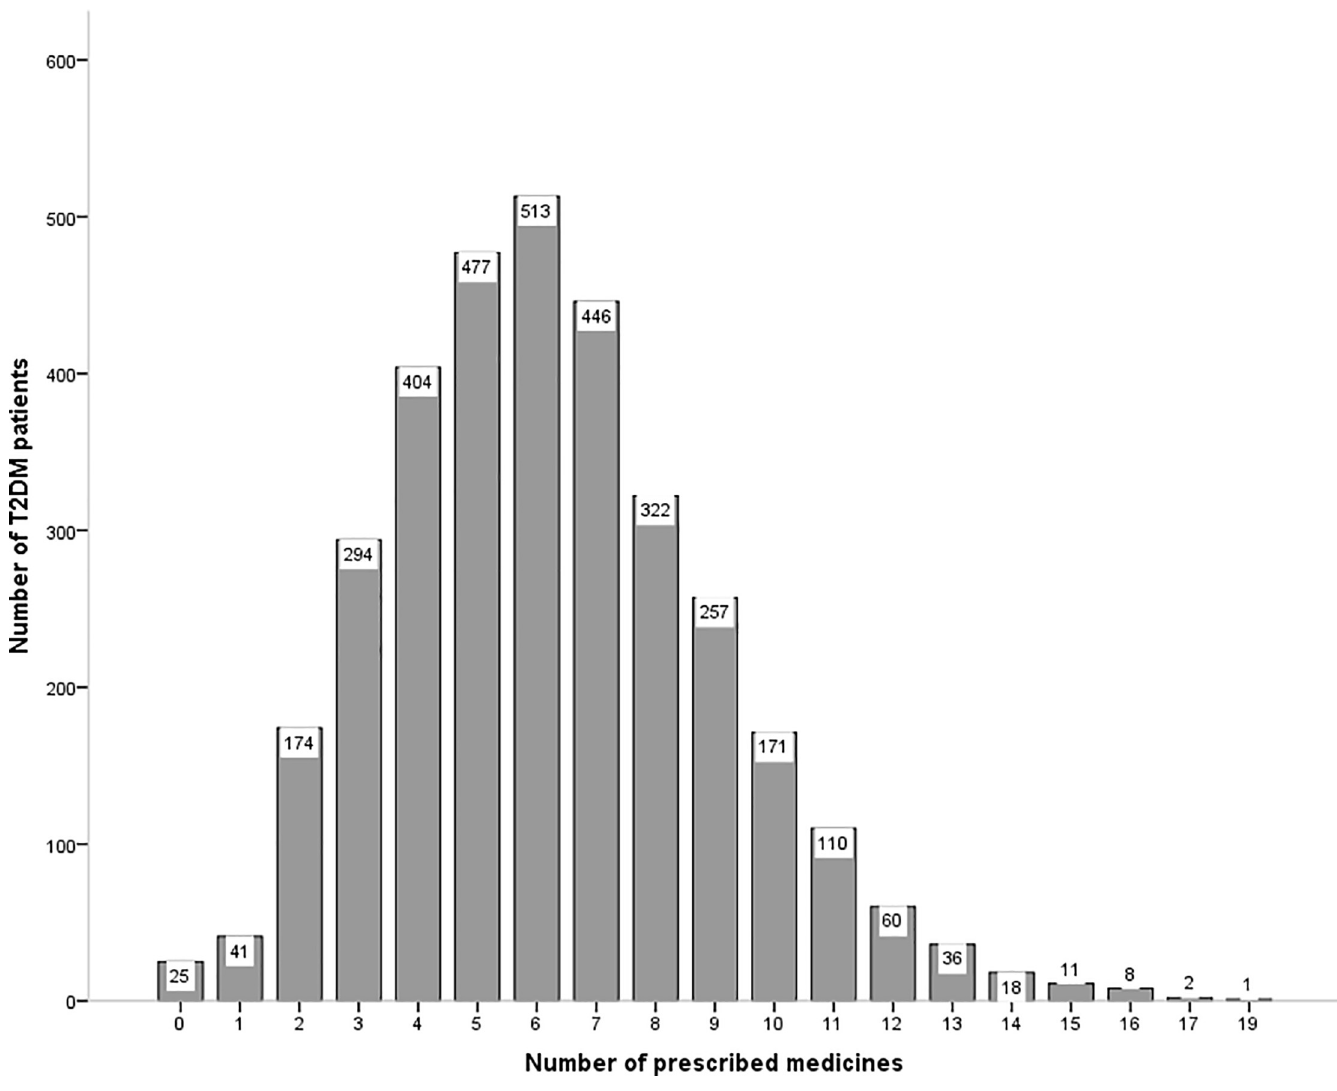
Fig 1. Number of prescribed medicines in our